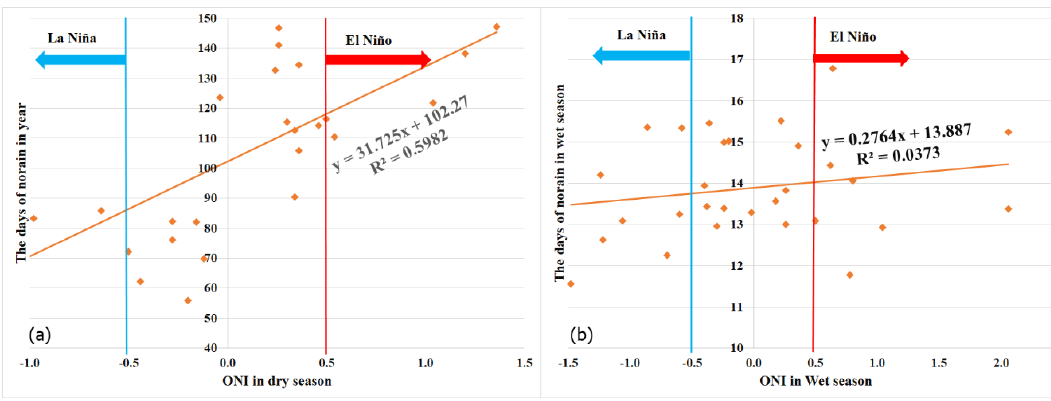
Figure 12. Relationship between drought and ONI: ( a ) NRY and average ONI in the dry season and ( b ) NRW and average ONI in the rainy season.